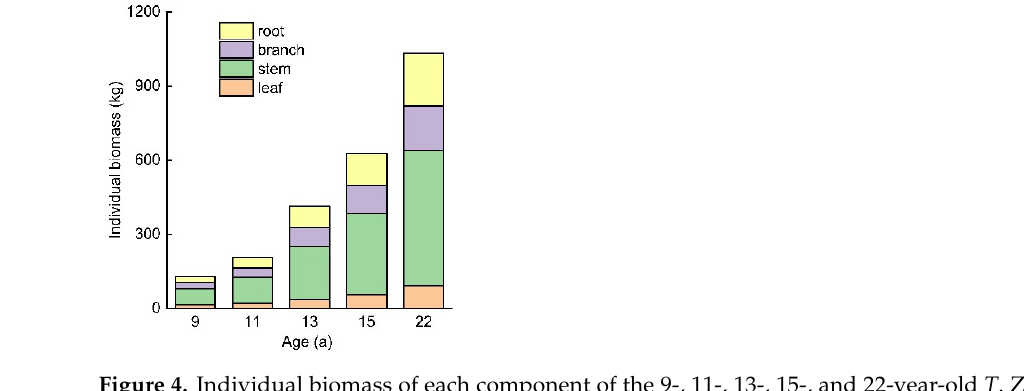
Figure 4. Individual biomass of each component of the 9-, 11-, 13-, 15-, and 22-year-old T . Zhongshanshan plants.